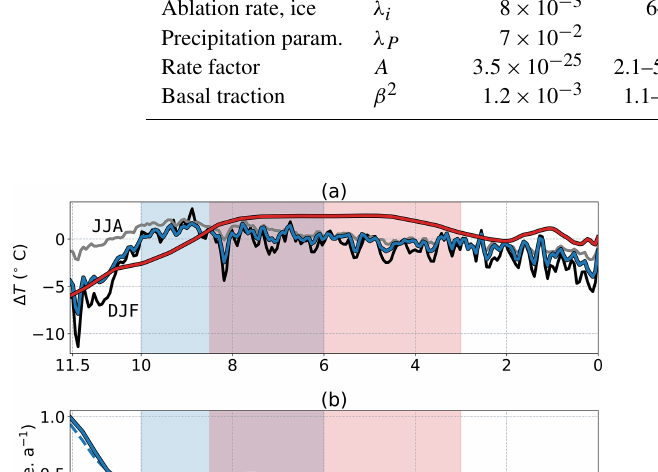
Figure 7. Average precipitation (both solid and liquid) on the north- ern flow line from the Buizert et al. (2018) reconstruction (black line), which is based on the TraCE-21ka coupled ocean–atmosphere general circulation model of the last deglaciation versus estimated precipitation derived in this work based on reconciling the modeled and observed retreat chronologies (blue